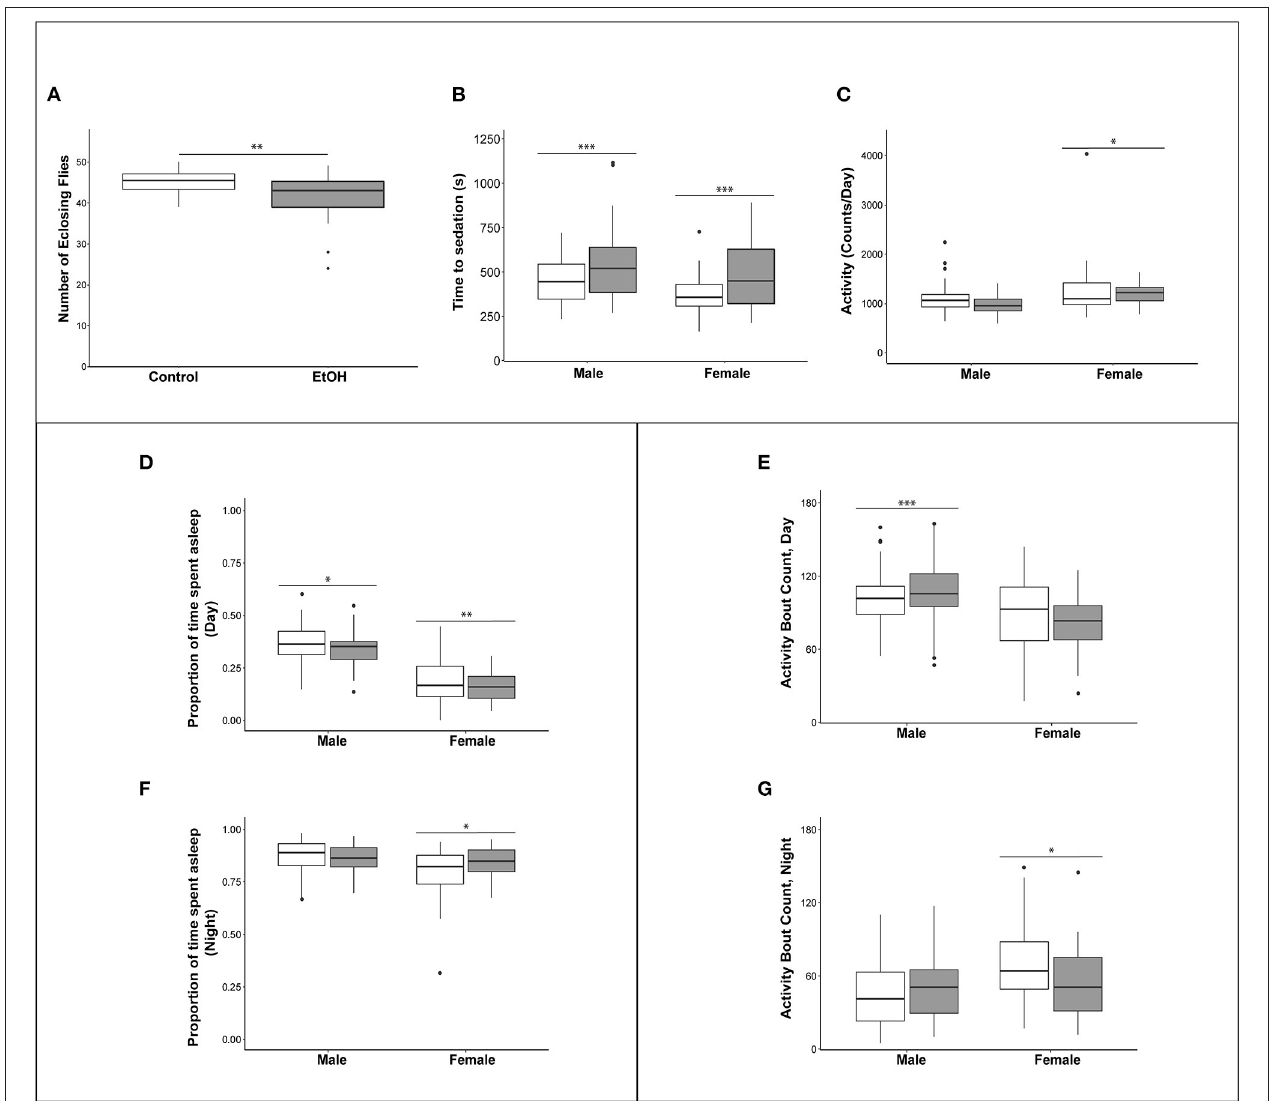
FIGURE 2 | Effects of developmental alcohol exposure on viability and behavioral phenotypes in adult flies. (A) Boxplots of viability ( n = 12 reps of 50 embryos per treatment), (B) Ethanol sensitivity ( n = 43–49, 3–5 day old flies per sex per treatment), (C) Activity, (D) Proportion of daytime sleep, (E) Activity bouts during the day. (F) Proportion of night time sleep, (G) Activity bouts during the night. Day hours are from 7a.m. to 7 p.m., lights on 7h after hour zero. Gray boxes indicate flies reared on medium supplemented with 10% (v/v) ethanol and white boxes indicate control flies grown on regular medium. n = 57–64 flies per sex per treatment for all sleep and activity phenotypes. * p < 0.05, ** p < 0.01, *** p < 0.001. Actograms are shown in Supplementary Figure 1